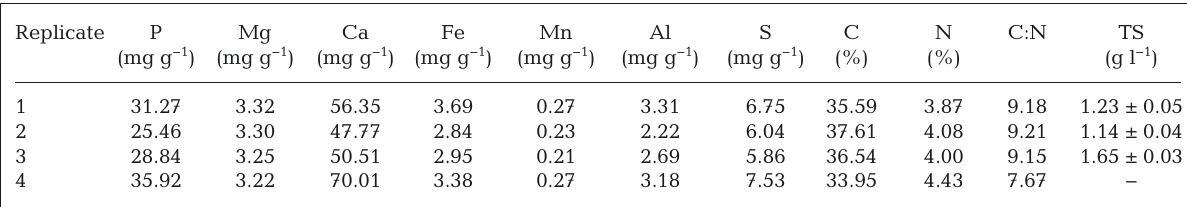
Table 2. Elemental analysis by inductively coupled plasma optical emission spectrometry, C:N ratio and total solids (TS) of freeze-dried sludge collected from the clarifier (1.5 m 3 ) of a recirculating aquaculture system producing tilapia under realistic conditions in 4 technical replicates, illustrating the respective variation in sludge harvested during the experimental